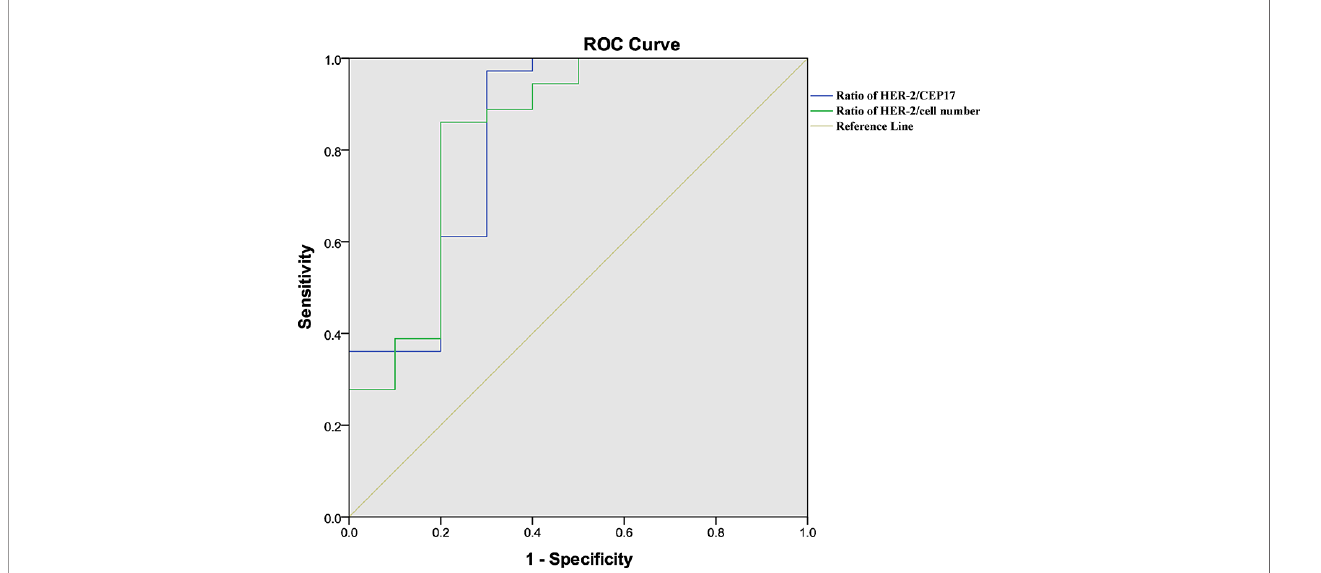
FIGURE 1 | Results of ROC analysis. (green) ROC analysis of the ratio of HER-2/CEP17 with pCR. (blue) ROC analysis of the ratio of HER-2/cell number with pCR. p<0.05 was considered statistically signi fi